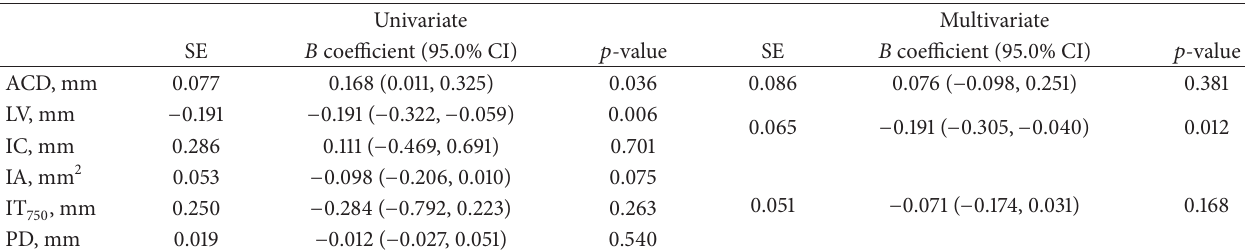
) assessed post-LPI in the NBG subjects. (AOD 750